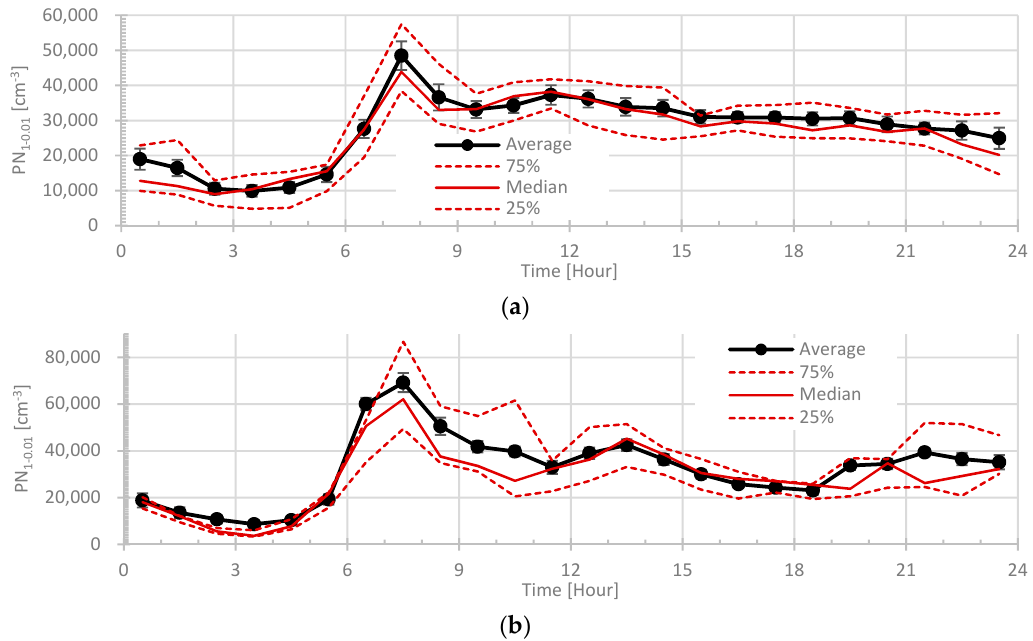
Figure 1. Workday diurnal patterns of submicron particle number concentrations (PN 1–0.01 ) measured at the reference urban background sites during the pre-campaigns: ( a ) the campus of the University of Jordan and ( b ) Ma’asom in Zarqa. Atmosphere 2019 , 10 , x FOR PEER REVIEW 0.11.010.0100.0